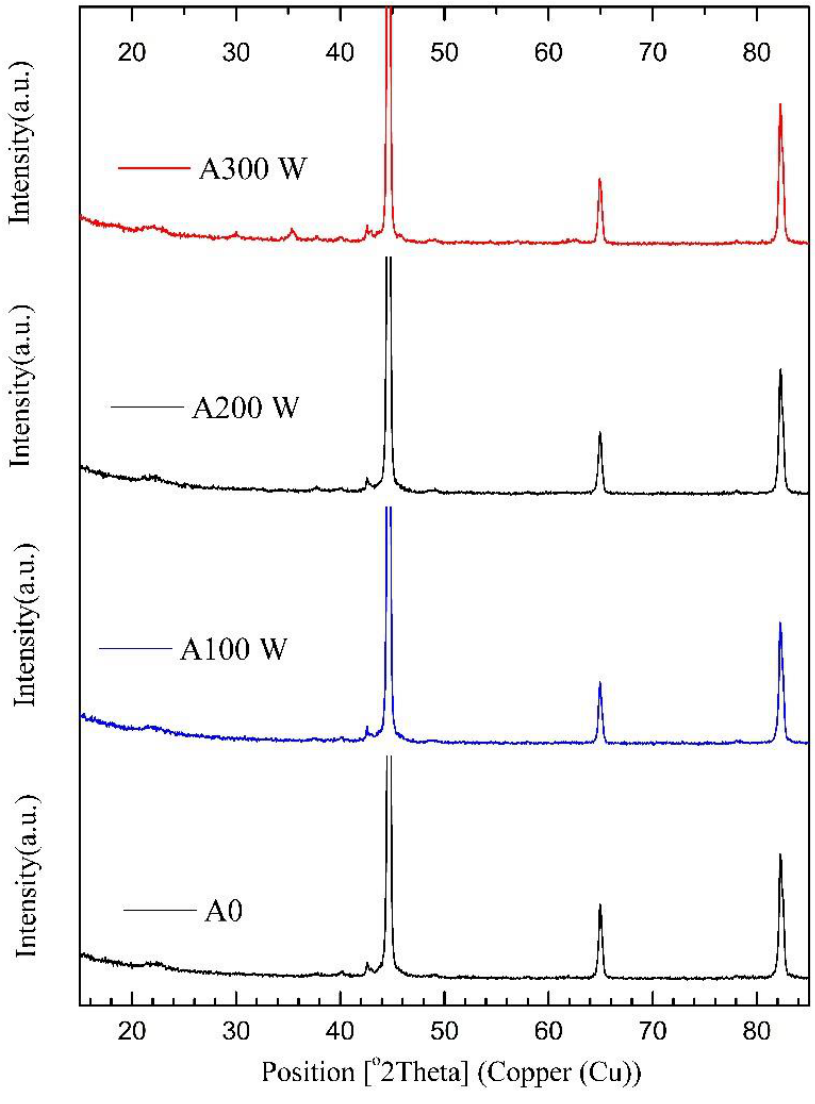
Figure 4. XRD patterns of RIE-treated samples—10 min at different RF power in 13.3 Pa (100 mTorr) N 2 -Ar gas mixture. All pronounced peaks belong to cubic iron, and the minor peaks belong to cubic Fe 3 O 4.